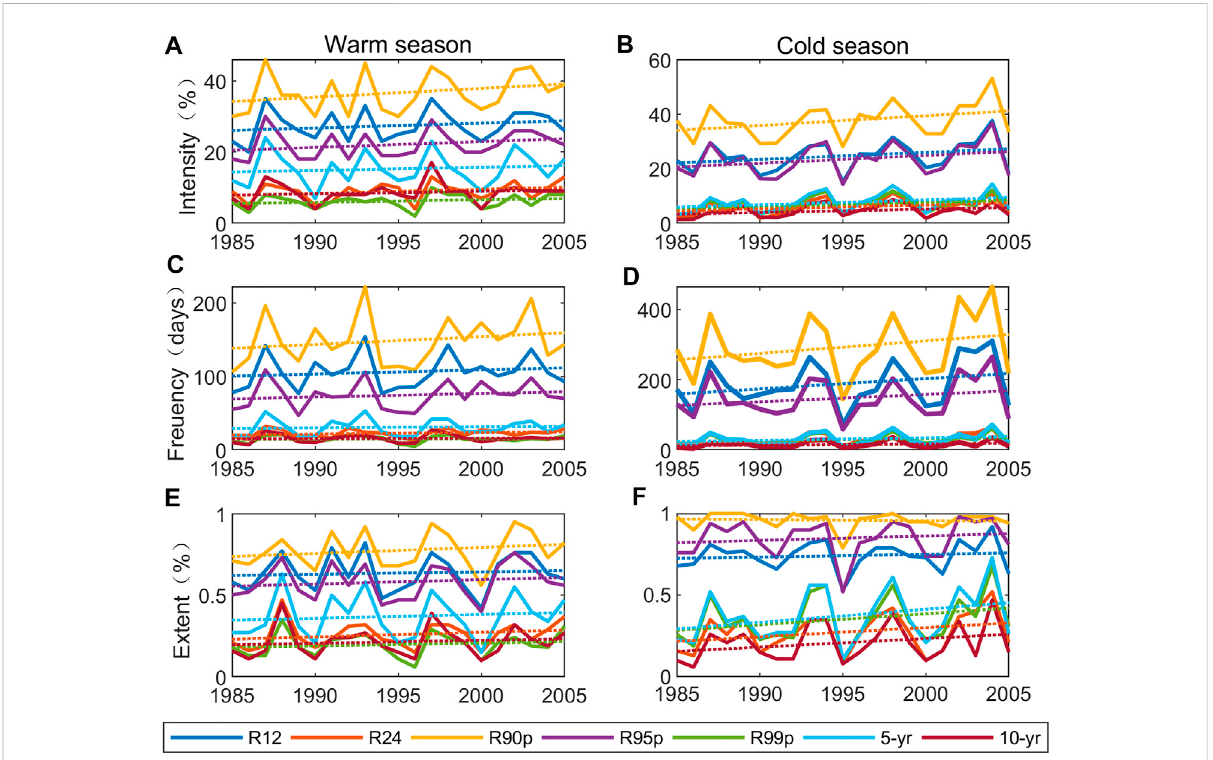
FIGURE 5 The variation (solid line) and trend (dotted line) of intensity (A,B) , frequency (C,D) and extent (E,F) of extreme precipitation by seven threshold criteria in Central Asia from 1985 to